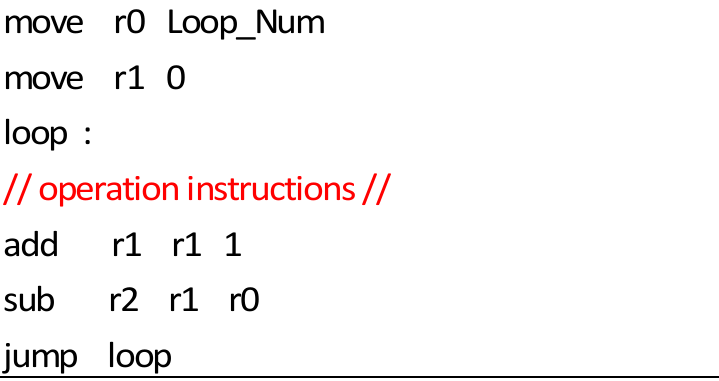
Figure 4. Traditional loop assembly code.